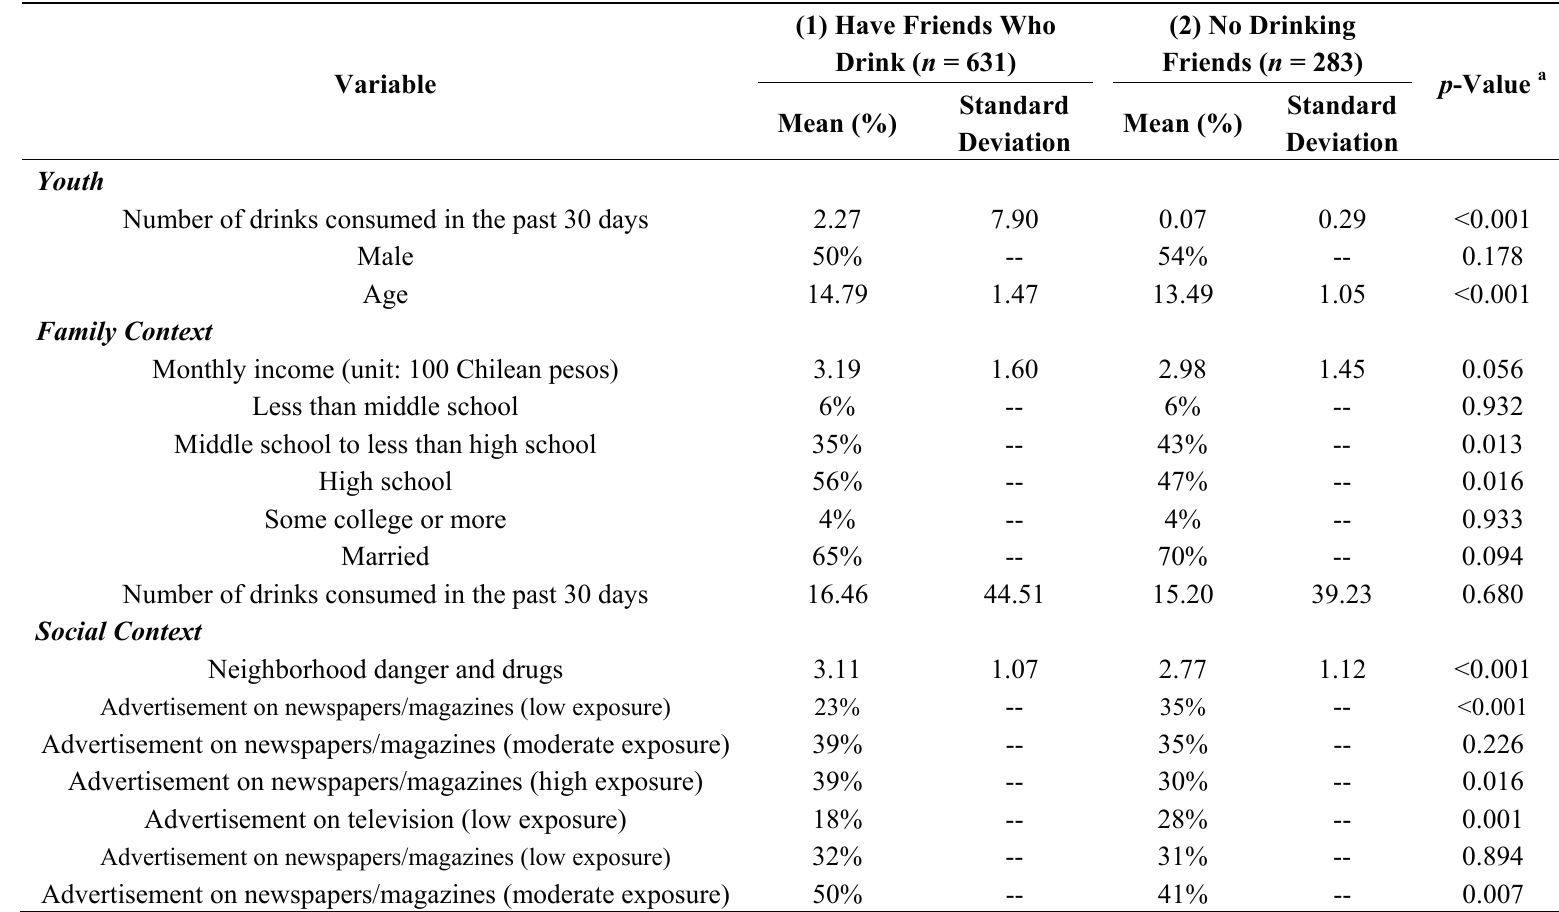
Table 1. Descriptive Statistics of Youth by Peer-Drinking